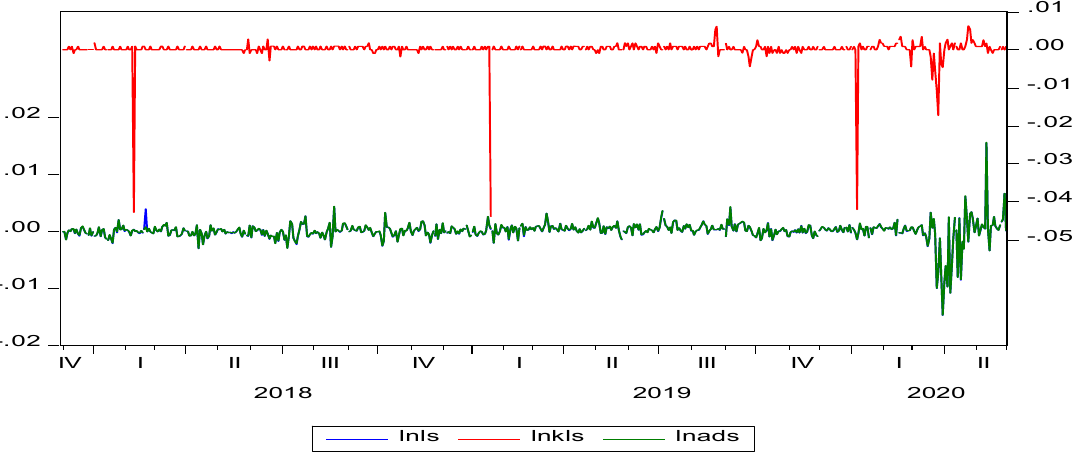
Figure 2. Daily returns of London Sukuk, Kulala Lumpur Sukuk and Abu Dhabi Sukuk indices prices.